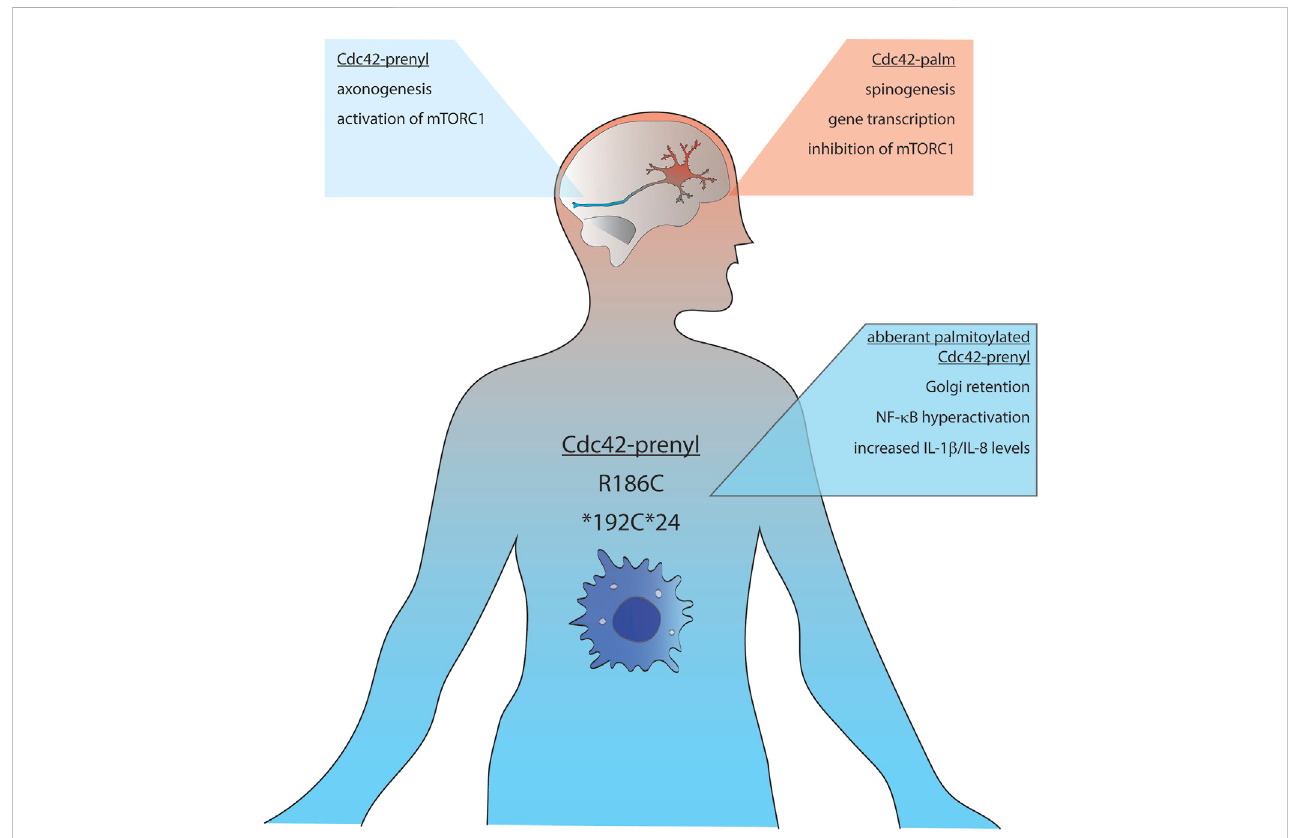
Schematic representation of the distribution and functions of Cdc42-palm (red background) and Cdc42-prenyl (blue background) isoforms. mTORC1, mammalian target of rapamycin complex 1; IL, interleukin; NF- κ B, nuclear factor kappa-light-chain-enhancer of activated B